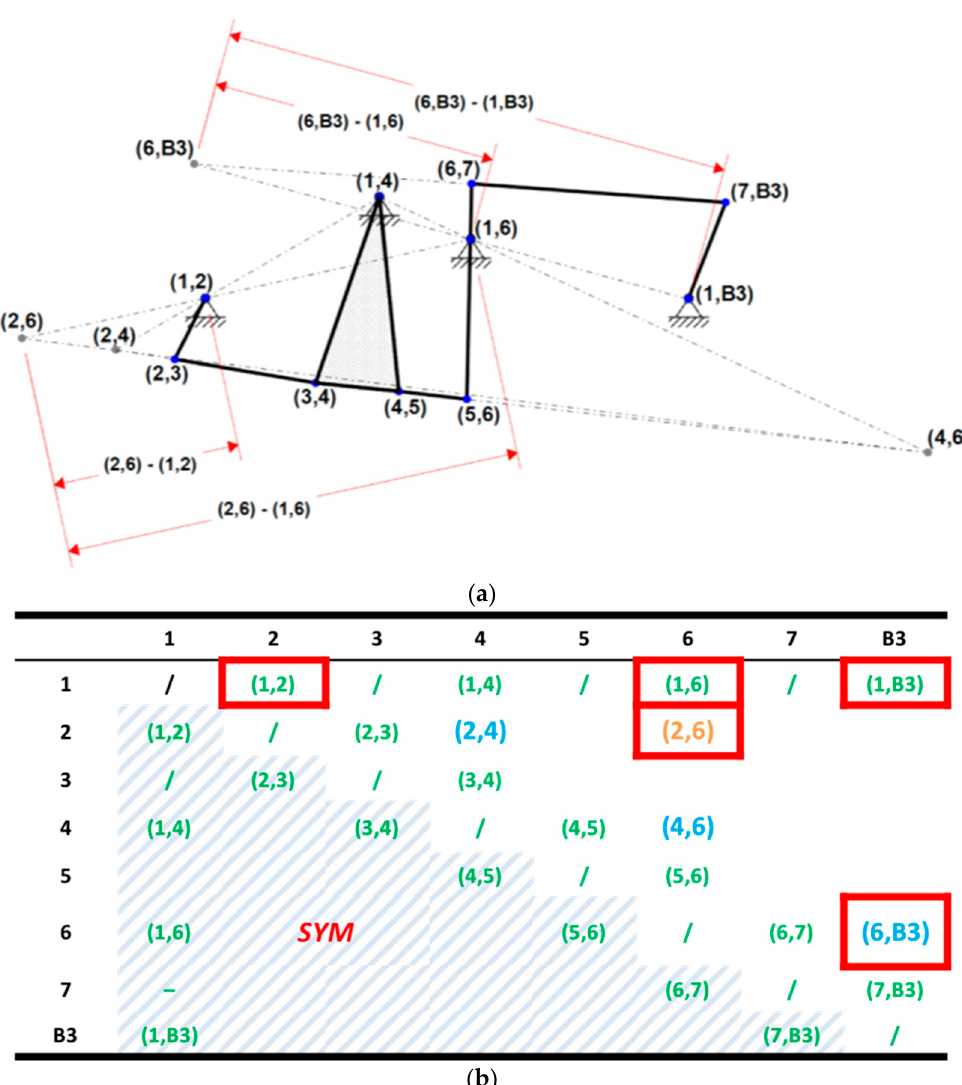
Figure 10. Inner mechanism instant centres analysis: ( a ) Construction of the instant centres by means of AK lines; ( b ) IC matrix of the linkage: main hinges (labelled in green), first order ICs (labelled in blue), second order IC (labelled in orange) and required ICs for MA estimation (marked in red).